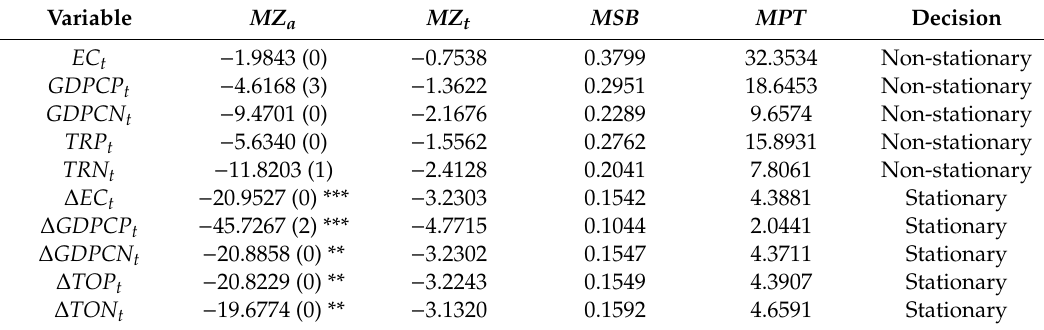
Table 1. Unit Root Results.